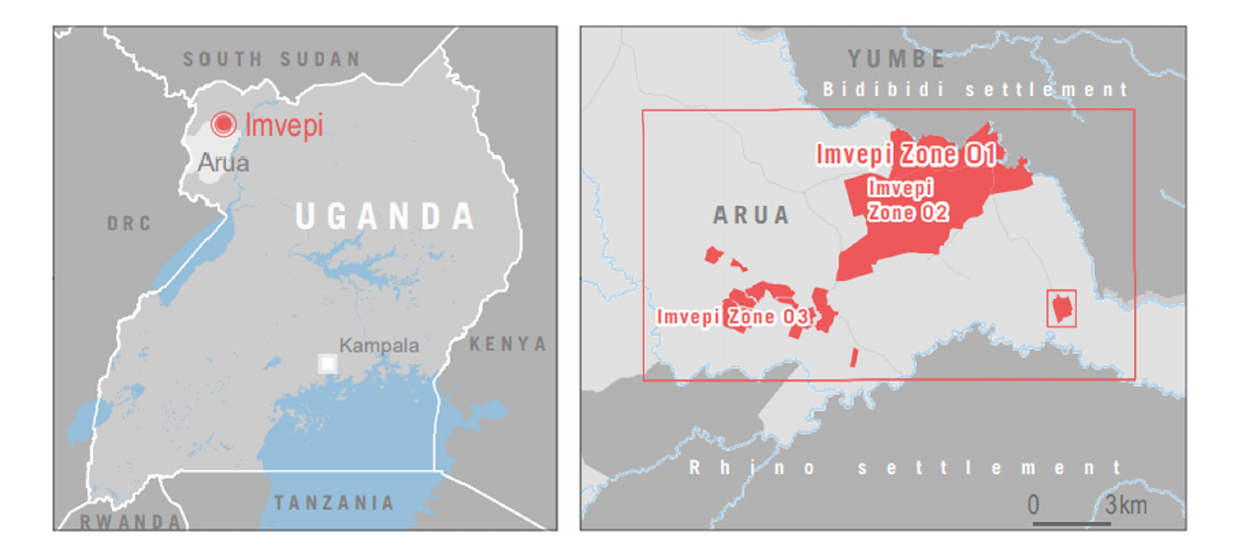
FIGURE 1 Study area. Administrative boundaries: UBOS; Natural features: © OpenStreetMap Contributors, UNHCR; Roads: © OpenStreetMap Contributors; UNHCR; Settlement boundaries and infrastructures: © OpenStreetMap Contributors, REACH Initiative, UNHCR; Coordinate System: WGS 1984 UTM Zone 36 N.